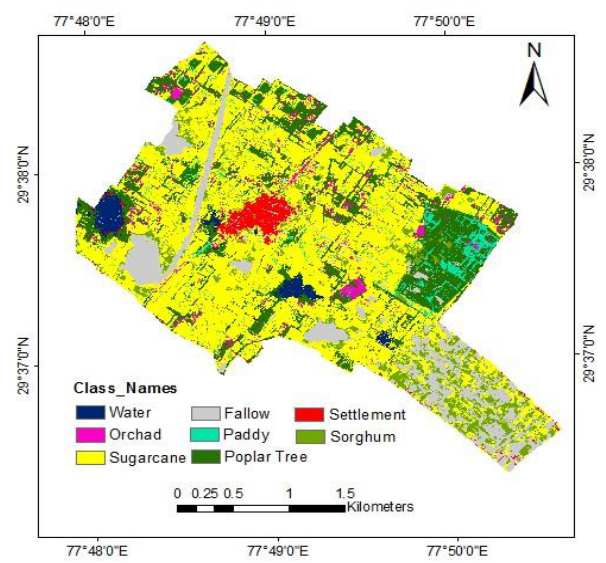
Figure 8. Classified image using decision tree (VI &